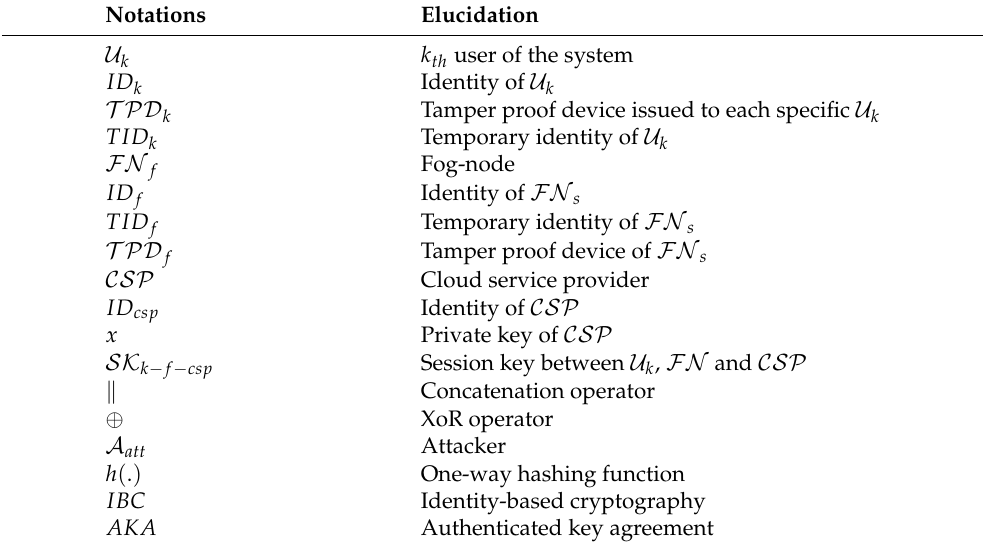
Table 2. Commonly used